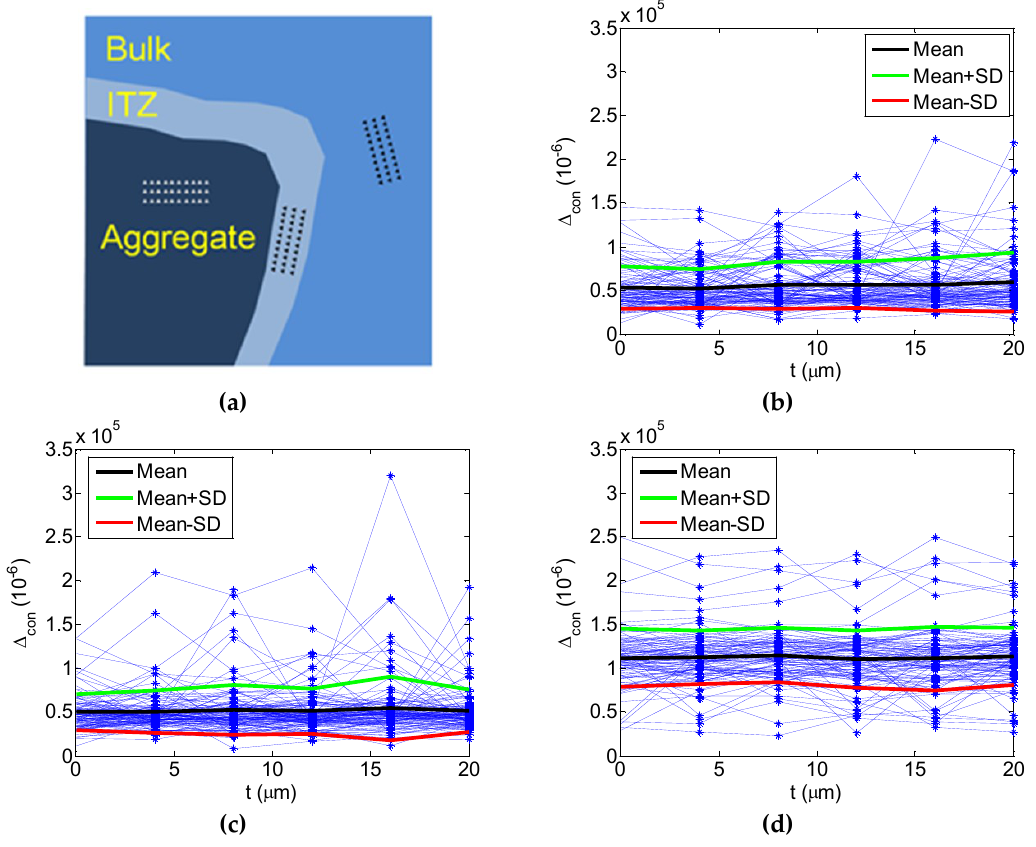
Figure 6. 1D random filed observations: ( a ) the indent zones; the samples, the mean and the standard deviation for the constrained SFS of ( b ) HCP, ( c ) ITZ and ( d ) aggregate.